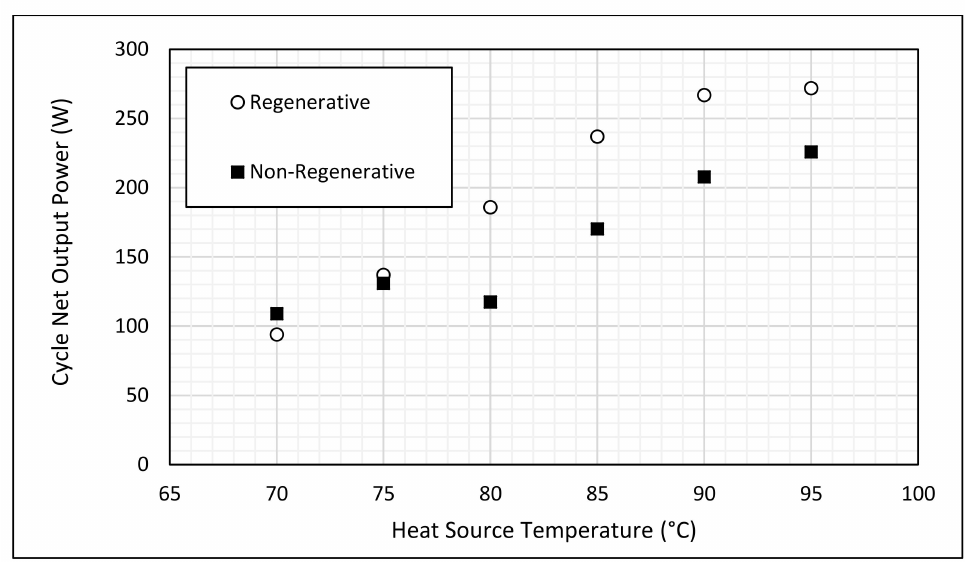
Figure 6. Variation in cycle net power output with varying heat source temperatures for regenerative and non-regenerative cycles, for a pump speed of 40 Hz.